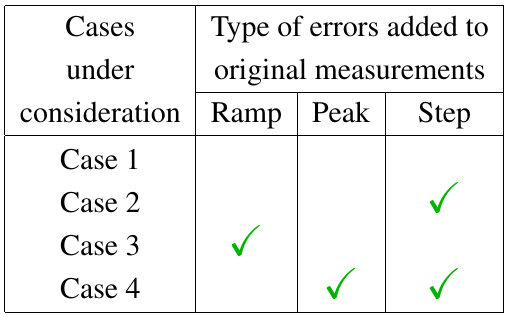
Table 2. Outlying patterns added to the original measurements to evaluate the RoPEUS algorithm